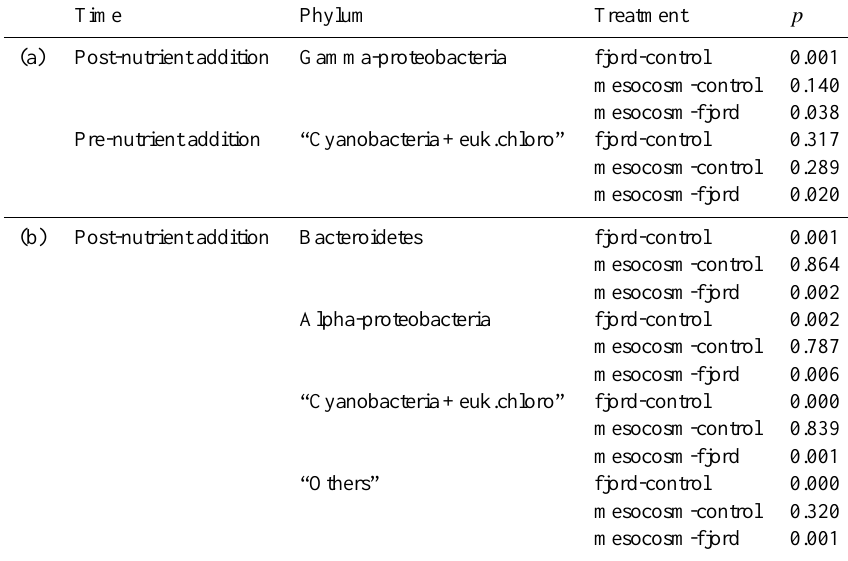
Table 3. Analysis of variance (ANOVA) showing the relationship in between each treatment pre- and post-bloom condition for (a) small and (b) large size fraction bacteria of phyla with significant differences. Significant values are p < 0 . 05.